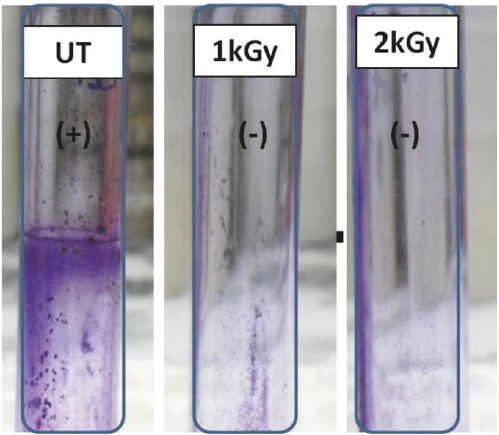
Figure 2: Biofilm production on glass tubes before (UT) and after gamma radiation at 1kGy and 2 KGy doses. ( − ) indicates lack of pellicles and (+) indicates the presence of pellicles. UT: untreated